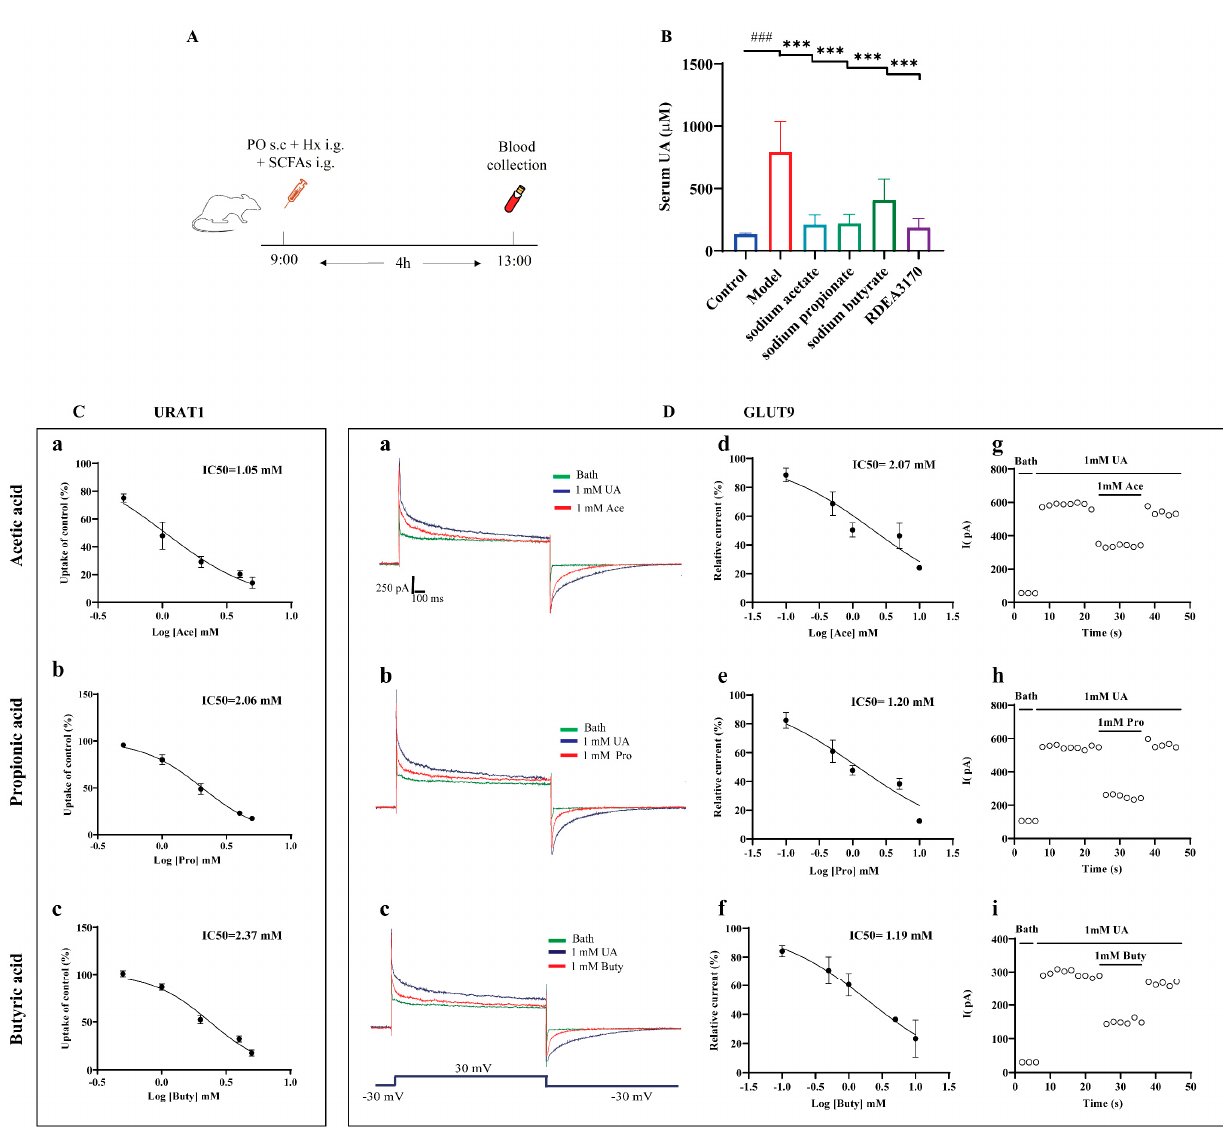
Figure 8. Effect of SCFAs on serum UA levels in PO + Hx-induced hyperuricemic mice and URAT1- and GLUT9-mediated urate transport in over-expressing HEK293T cells. ( A ) Experimental schematic of SCFAs treatment. ( B ) Serum UA ( n = 6). ( C ) Effects of acetic acid ( a ), propionic acid ( b ), and butyric acid ( c ) on the transport activity of URAT1 ( n = 6). ( D ) Effects of acetic acid, propionic acid, and butyric acid on GLUT9-mediated urate transport: (a–c) original current traces of GLUT9-expressing HEK-293T cells induced by 1 mM UA in the presence (red) or absence (blue) of 1 mM acetic acid, propionic acid, and butyric acid; ( d – f ) dose ‐ dependent inhibition of acetic acid, propionic acid, and butyric acid on GLUT9; ( g – i ) time ‐ course of current with the perfusion of 1 mM acetic acid, propionic acid, and butyric acid after stimulation with 1 mM UA ( n = 6). Data are indicated as mean ± SD. ### p < 0.001, vs. the Control group; *** p < 0.001 vs. the Model group.